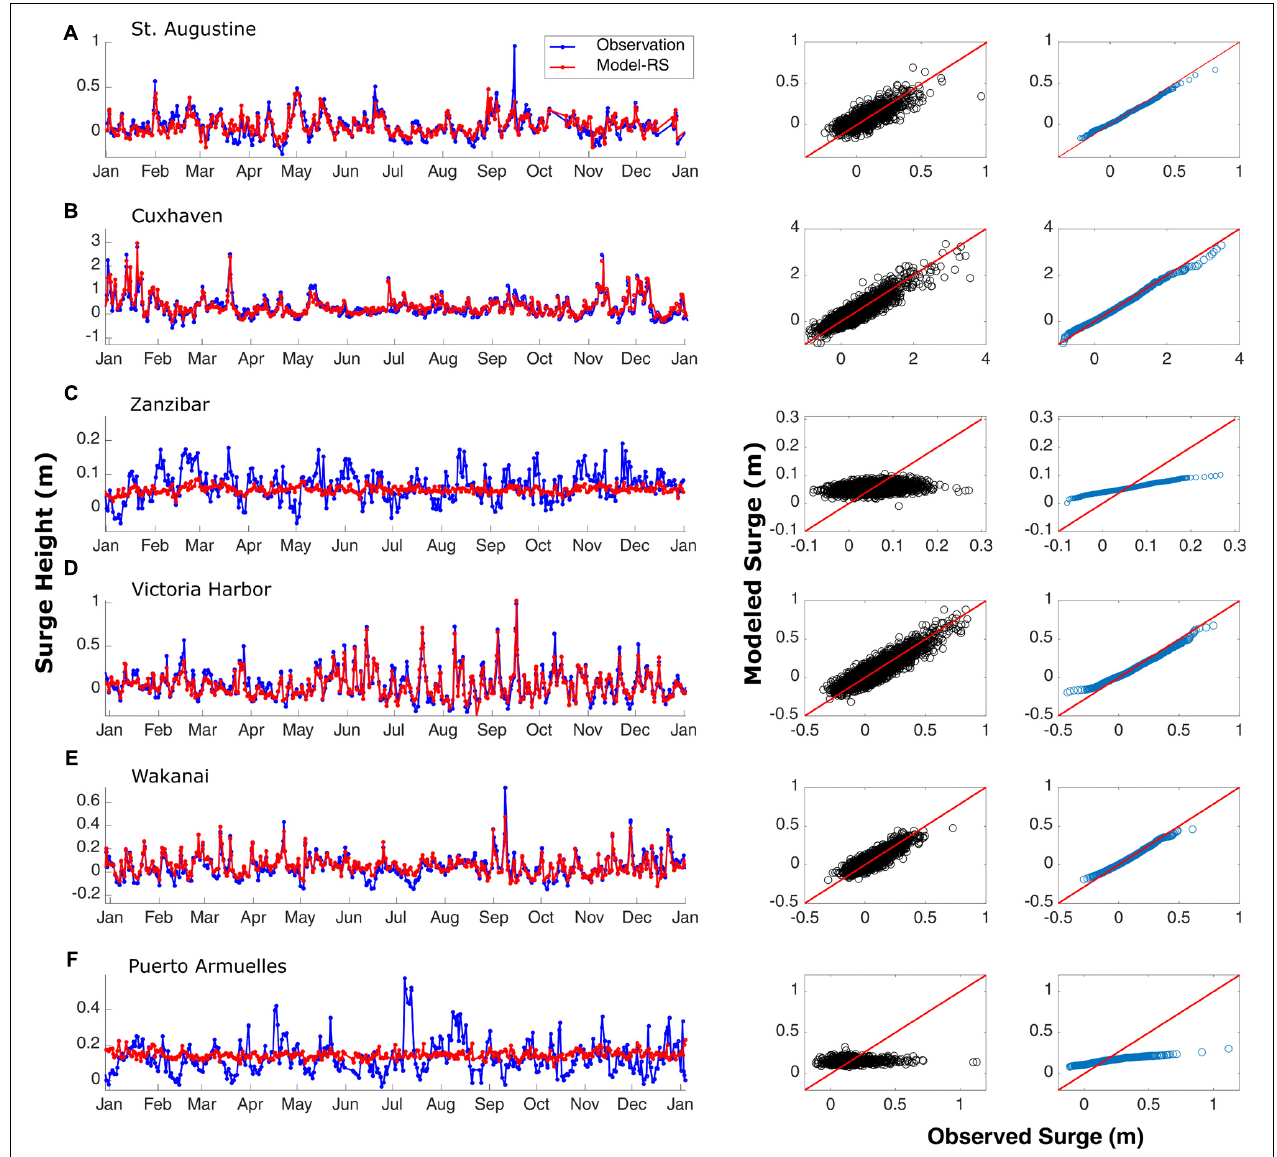
FIGURE 6 | Daily maximum surge time series comparison (left) , scatter plots (middle) , and quantile-quantile plots (right) for observed and modeled (Model-RS) daily maximum surge for six tide gage locations (marked in green in Figure 1